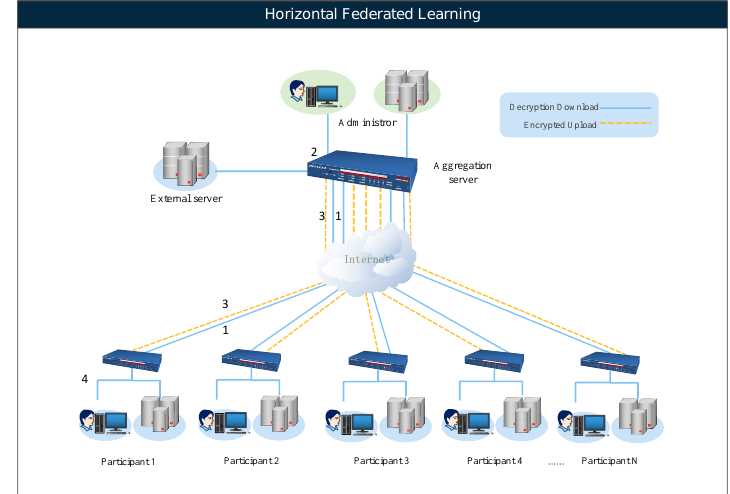
Figure 2. Horizontal federation learning client – server architecture.